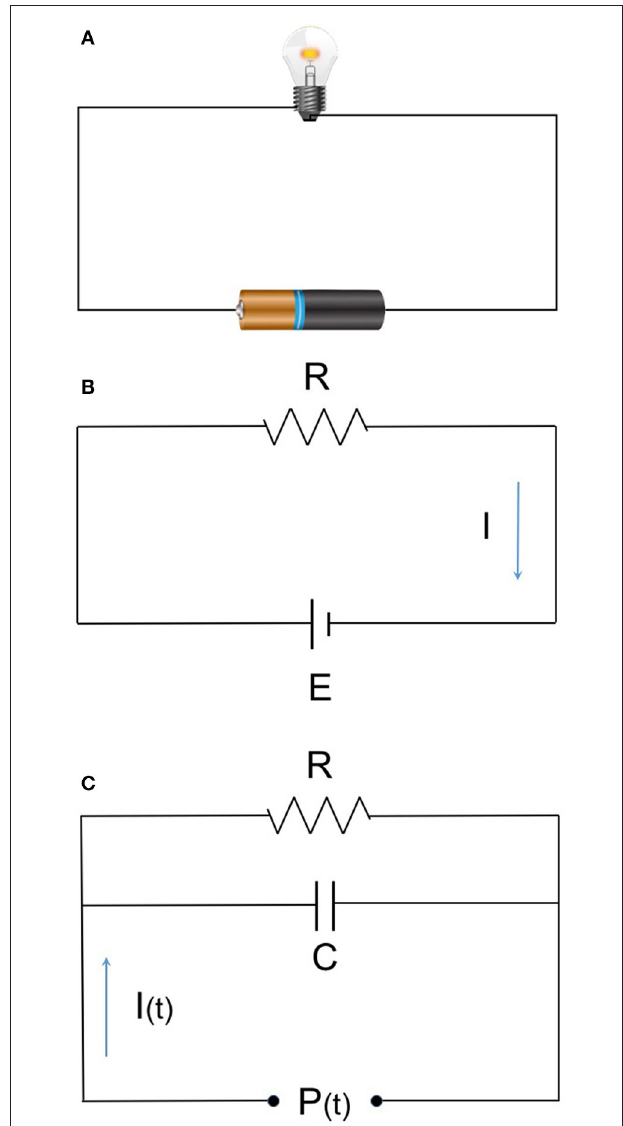
FIGURE 1 | (A) Ohm’s low and hemodynamic equation. (B) E (voltage) = I (current) × R (resistance) (MAP-CVP) = CO × SVR. MAP, mean